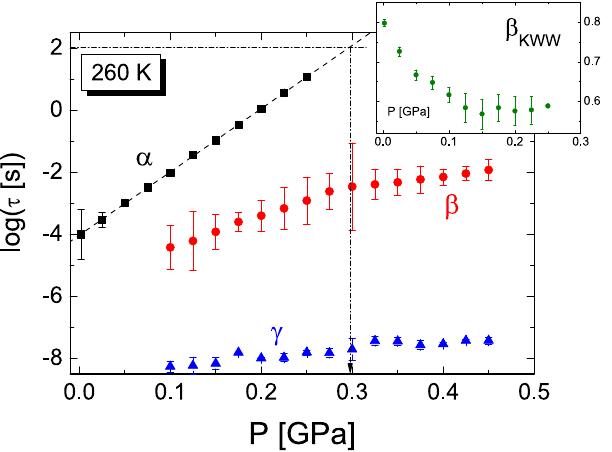
Figure 4. Relaxation times of the three different processes as function of pressure, for the isothermal measurements at 260 K. The vertical dashed line marks the value of P g at this temperature. Insets: β KWW stretched exponent as derived from the fit of the α relaxation peak, as function of pressure. Error bars are smaller than markers except where they are explicity